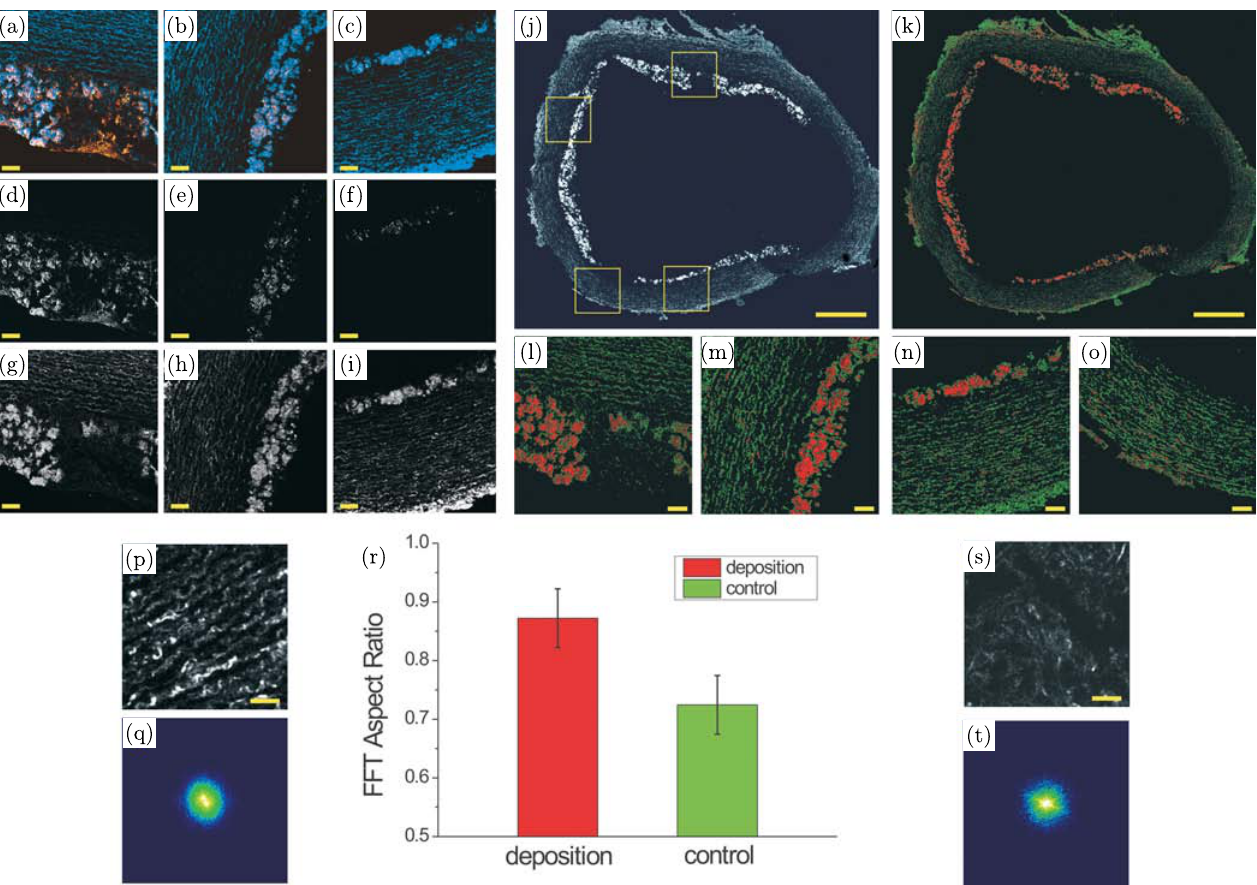
Fig. 2. Combined SHG-CARS nonlinear images of thin atherosclerotic arterial tissue sections from rabbit aorta. (a) – (c) Images showing a color merge of SHG (blue) and CARS (orange), acquired in regions with a di®erent level of plaque deposition. On the lower rows CARS (g) – (i) and SHG (d) – (f) are presented separately. Scale bars: 20 (cid:1) m. Tissue regions represented in images (a), (b) and (c), correspond to the regions represented in images (l), (m) and (n), respectively. (j) Combined F-SHG and B-SHG image of a thin cross section of rabbit aorta with atherosclerotic plaque depositions. (k) Color map coding for the F/B SHG ratio in a color coded scale. Black: F = B < 1. Green: 1 : 5 < F = B < 2 : 5. Red: F = B > 4. Scale bars: 0.5mm. Magni¯ed details of a region with high (l), mild (m), low (n) and no (o) plaque deposition. The images in (l) – (o) correspond to the regions indicated by yellow squares in (j). Scale bars: 20 (cid:1) m. SHG image of collagen within a control region (p) and a region with plaque depositions (s) with the corresponding FFT-images (q) – (t). Scale bars: 20 (cid:1) m. (r) Histogram distribution of the average Fast Fourier Transform (FFT) aspect ratio within control and deposition regions. Figure modi¯ed from Ref.